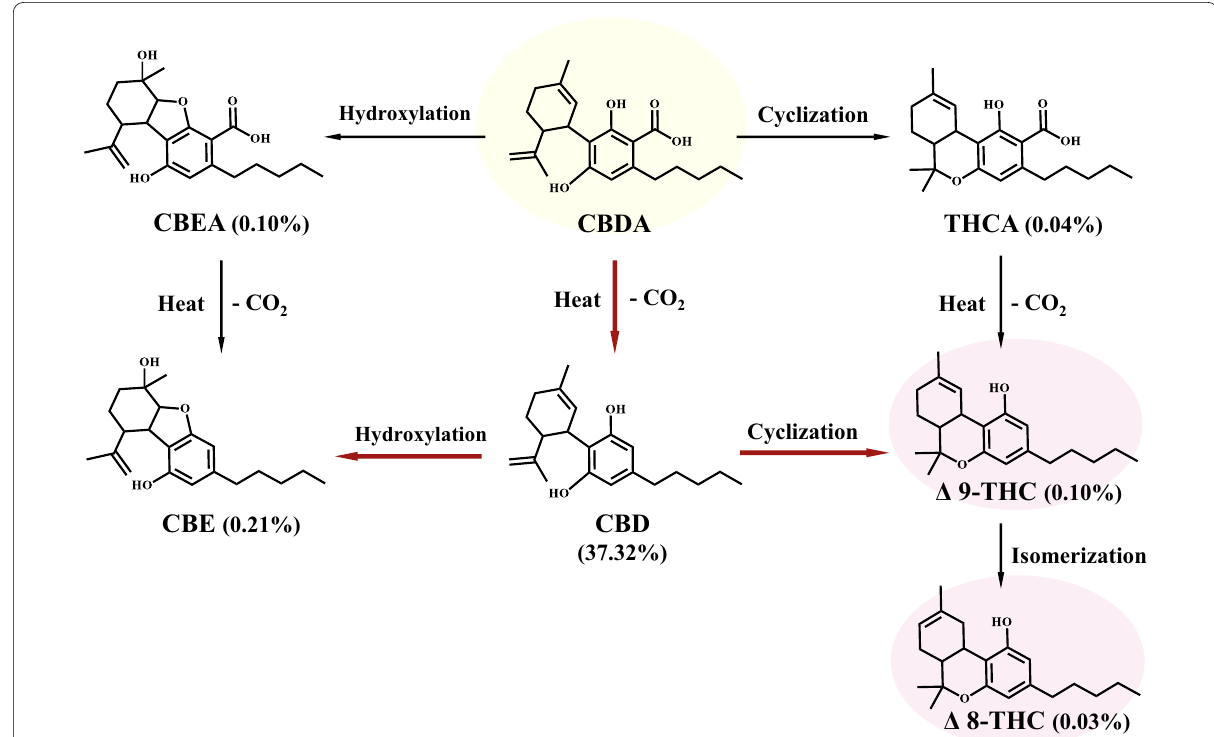
Fig. 6 Thermal transformation pathways of CBDA under thermal reaction at 130 °C for 30 min. Percentages are calculated using peak areas of total ion